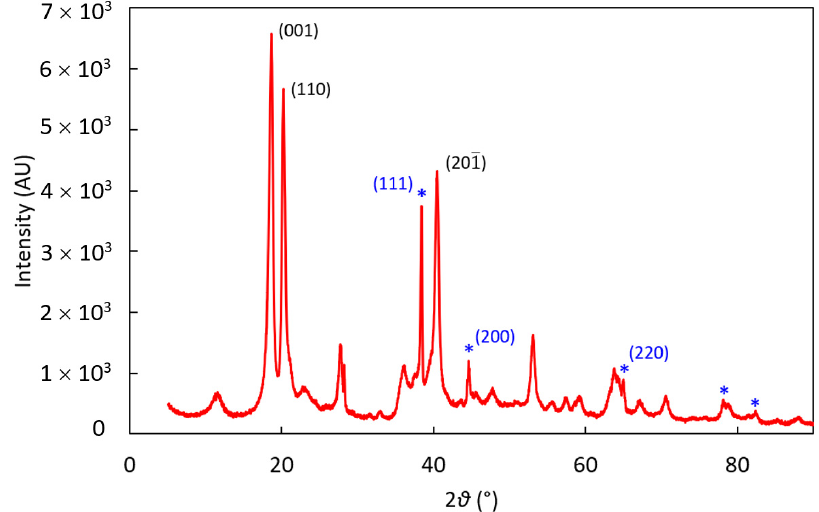
Figure 5. PXRD pattern for the white solid material recovered after 3 days hydrolysis of the 50% Al NPs/50% µ Al composite sample. Peaks labeled with * are due to elemental Al ( s ) (fcc Al, ICDD #00-004-0787) and all remaining peaks are attributable to Al(OH) 3 ( s ) (bayerite, ICDD #01-074-1119). The three strongest peaks for each identified phase are labeled with their Miller indices.